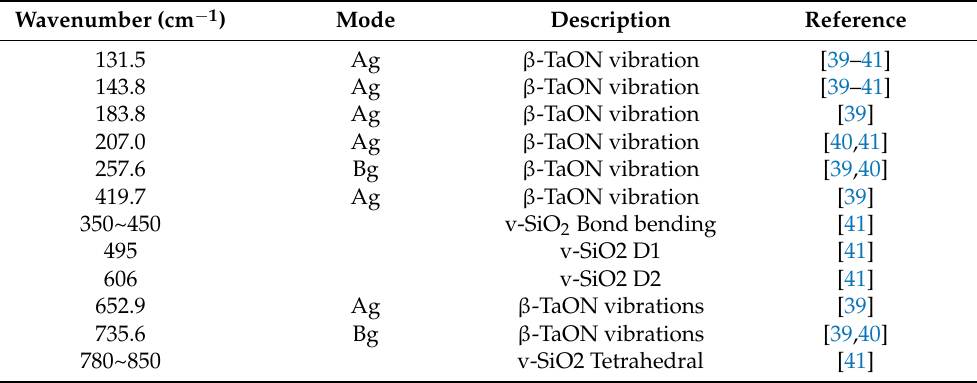
Table 2. Possible peaks in Raman spectra for tantalum oxynitride and silicon oxides